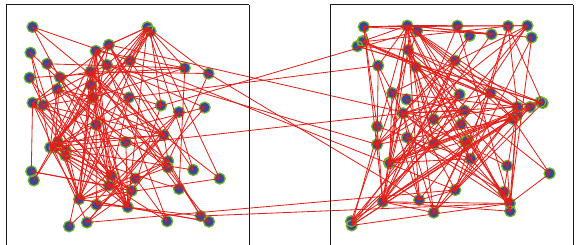
Figure 4: Topology structure of the undirected network consisting of 100 nodes, which are separated into two equal clusters. If there is an undirected link between node 𝑗 and node 𝑖 ( 𝑗 ̸= 𝑖 ), then 𝑎 𝑖𝑗 = 𝑎 = 1 , otherwise 𝑎 = 𝑎 = 0 . 𝑗𝑖 𝑖𝑗 𝑗𝑖